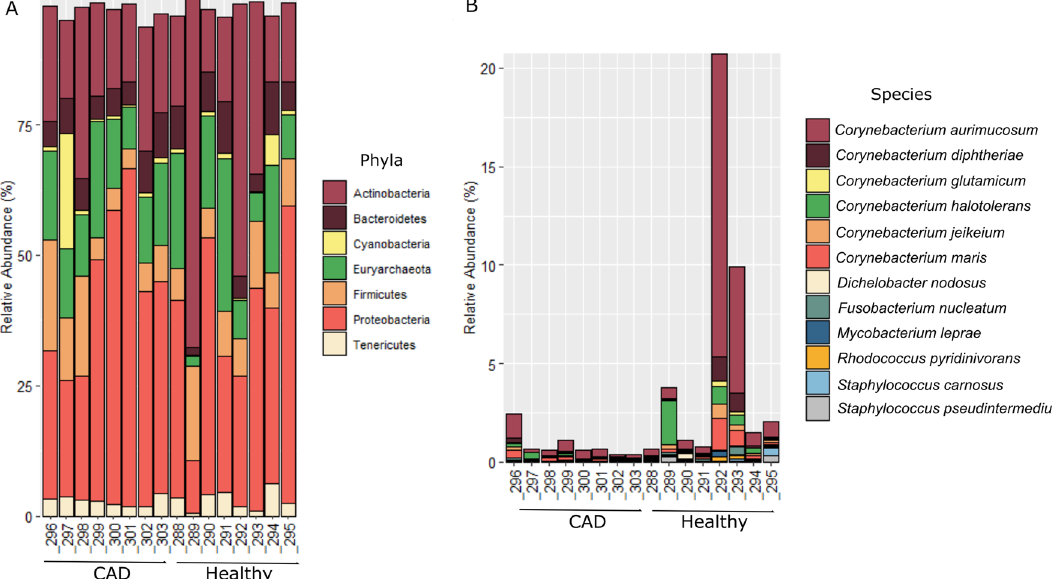
Figure 4. Taxonomic composition and relative abundance of the bacteria in CAD and healthy groups. ( A ) The most abundant phylum identified in the study, and ( B ) the 12 species differing significantly between the CAD and healthy